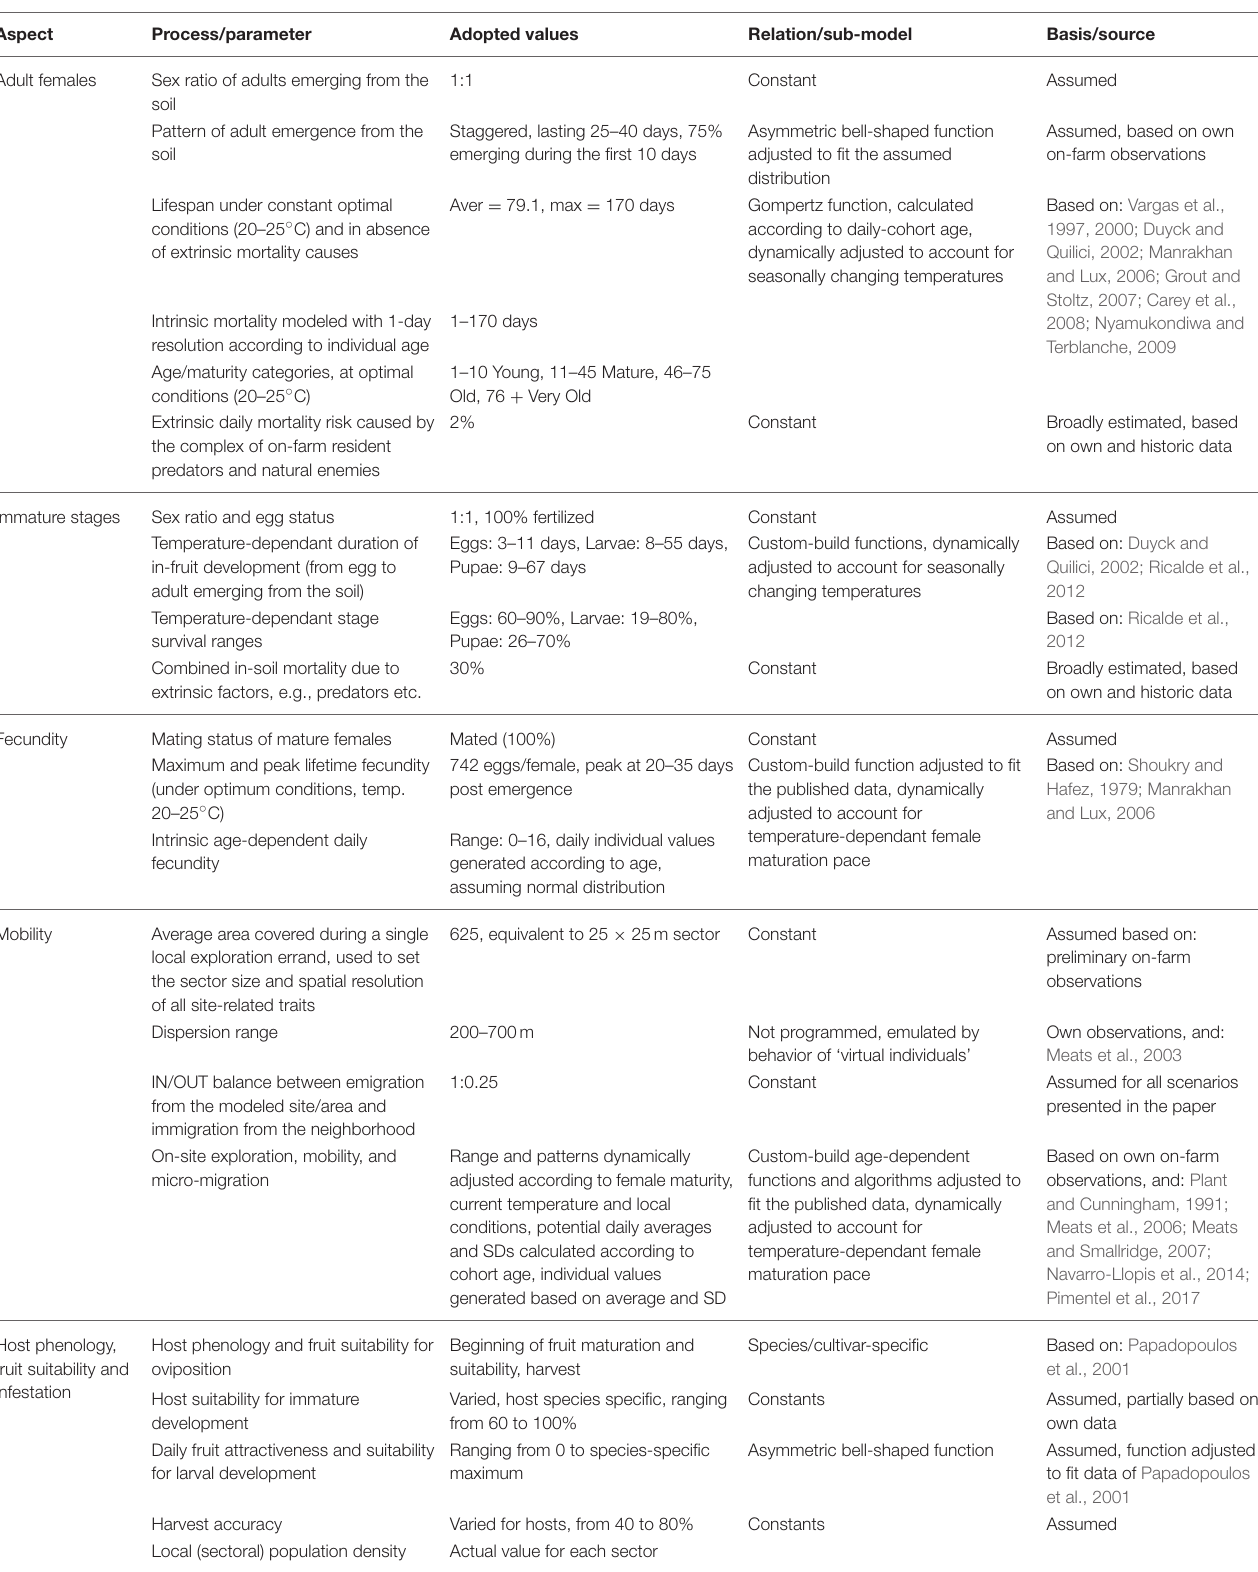
TABLE 1 | The main aspects of biology, key processes taken into account, sub-models and adopted parameters.